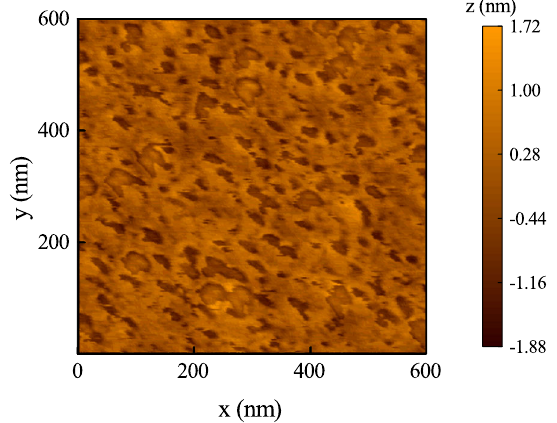
FIG. 10. AFM topography image of a TiN photocathode. The rms roughness is about 0.5